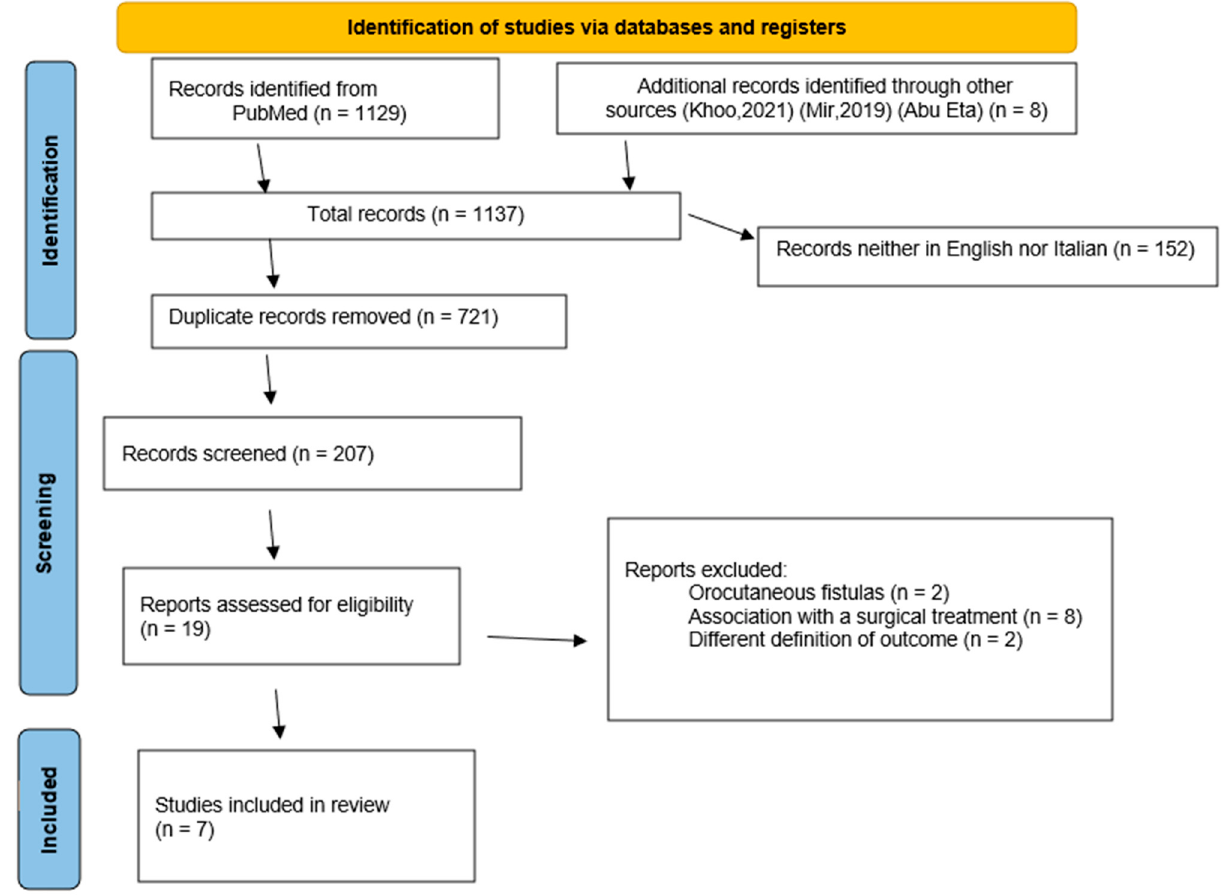
Figure 1. PRISMA flow diagram depicting the selection of the papers included in the present re- view.